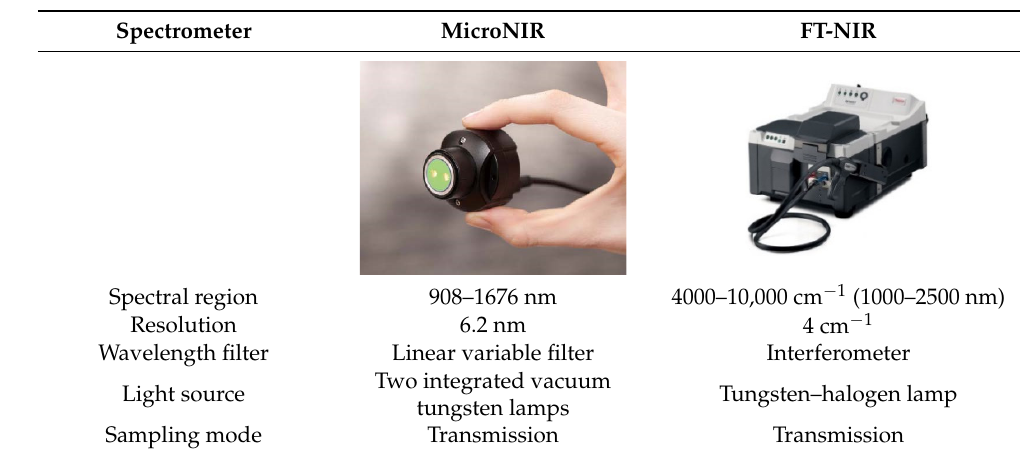
Table 3. Technical specifications of two NIR spectrometers.